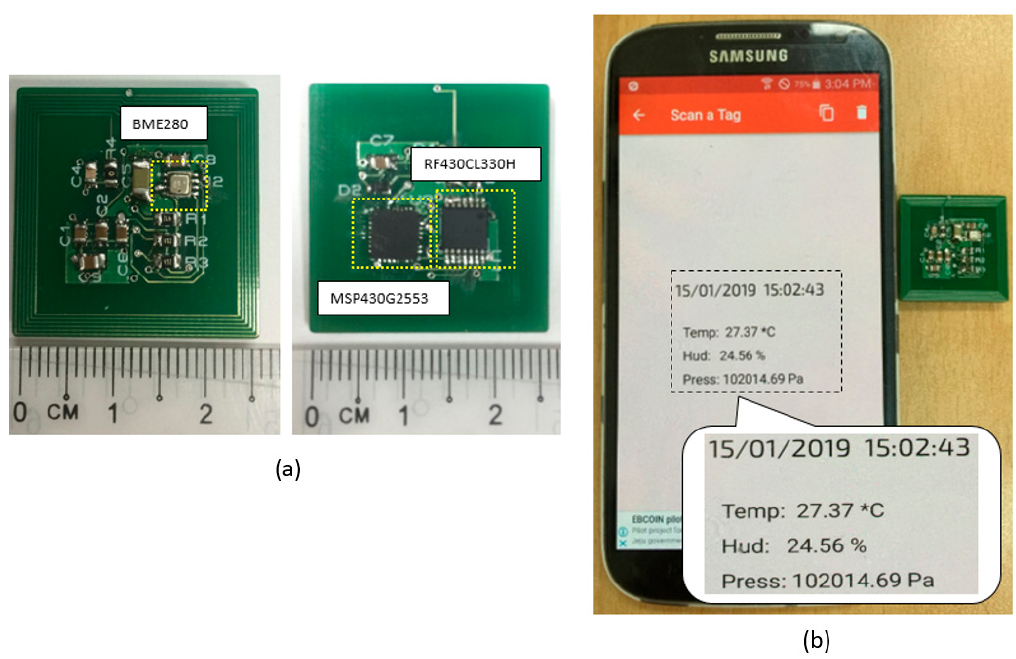
Figure 2. Experiments with the sensor tag: ( a ) top and bottom layers of the printed circuit board (PCB); ( b ) the measured data related to temperature, humidity, and air pressure acquired from the tag using an arbitrary smartphone.